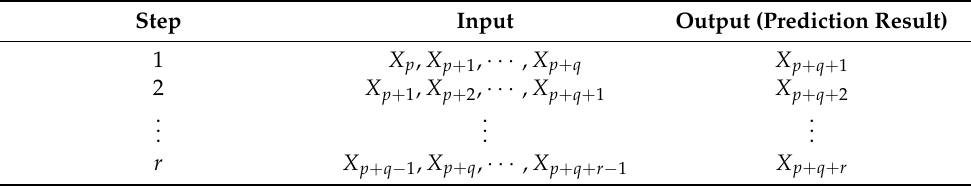
Table 3. Process of rolling